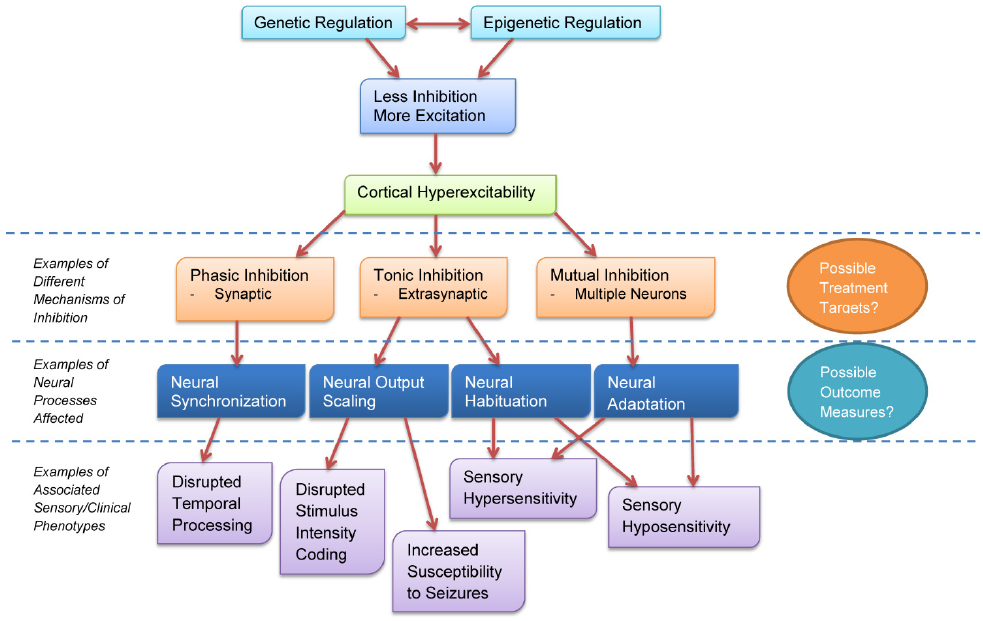
Figure 2. Cortical excitability affects neural inhibition through different mechanisms, each of which has cascading effects on sensory and clinical phenotypes in ASD.